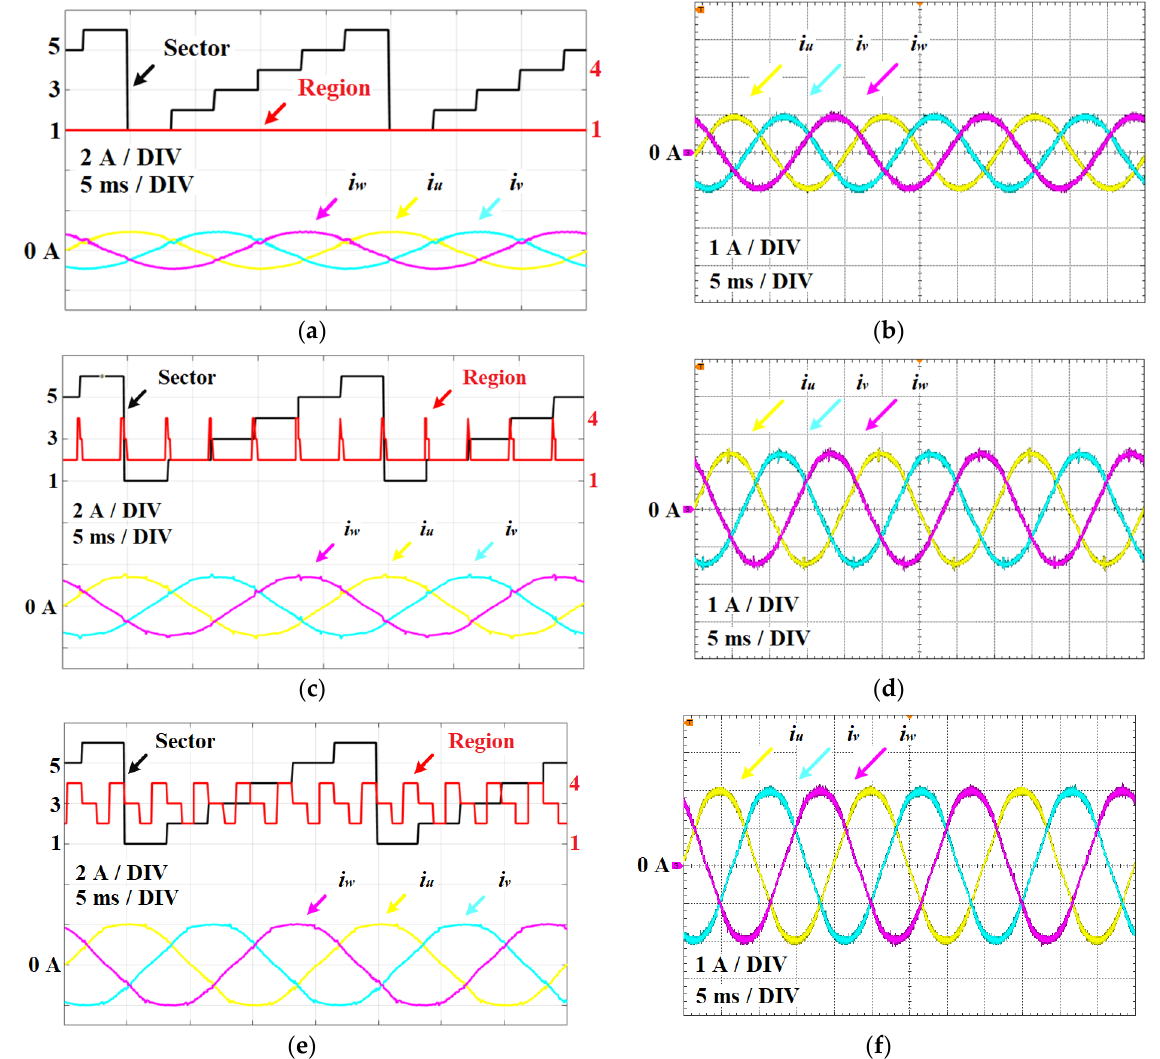
Figure 20. Single-shunt reconstruction of a three-phase current with SVM modification for f = 50 Hz: ( a ) m i = 0.4; ( c ) m i = 0.6; ( e ) m i = 0.8; scope-measured real three-phase currents for f = 50 Hz: ( b ) m i = 0.4; ( d ) m i = 0.6; ( f ) m i = 0.8. Table 11. Performance index for measurement results.